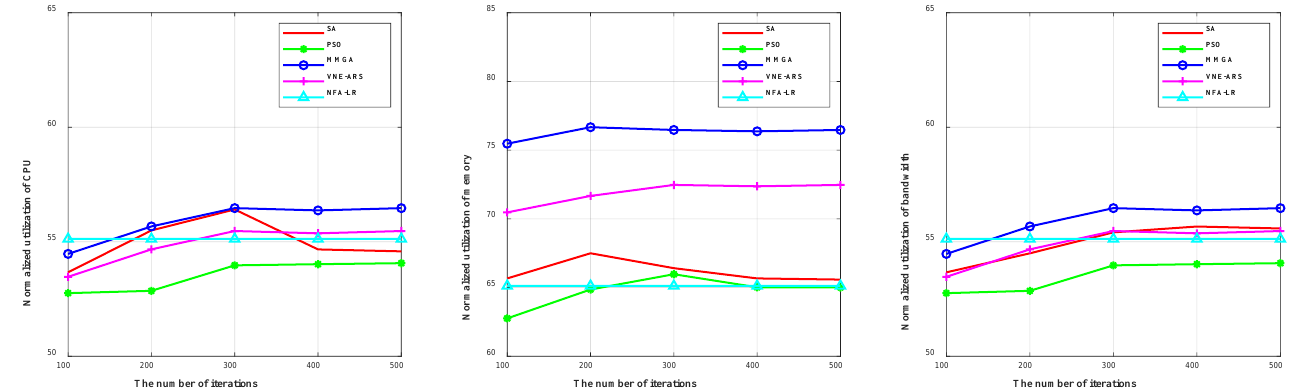
Figure 9. The CPU, memory, and bandwidth normalized utilization of different algorithms under the different number of iterations.